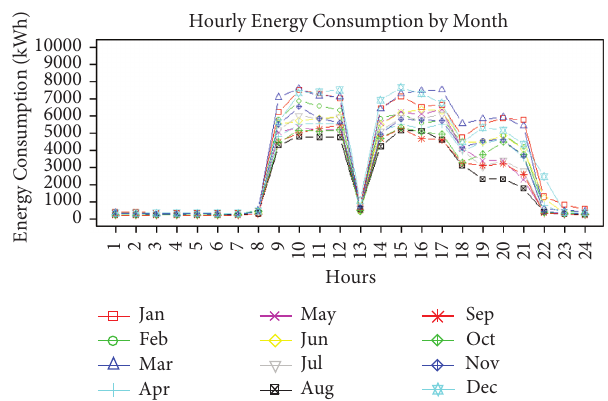
Figure 8: The diagram shows the per-month usage of energy for a steel factory in 2017.